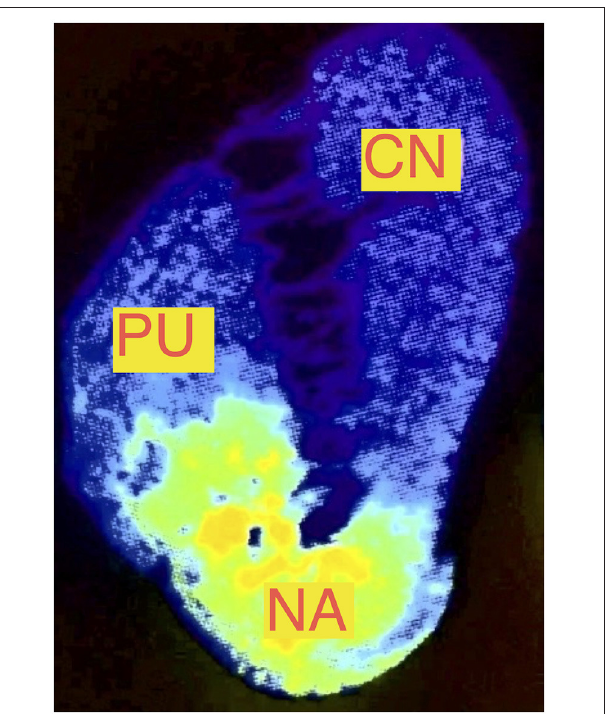
FIGURE 2 | PET examination of the nucleus accumbens showing the distribution of dopaminergic D3 receptors (NA, nucleus accumbens; CN, caudate nucleus; Pu, putamen) based on Gurevich et al. (